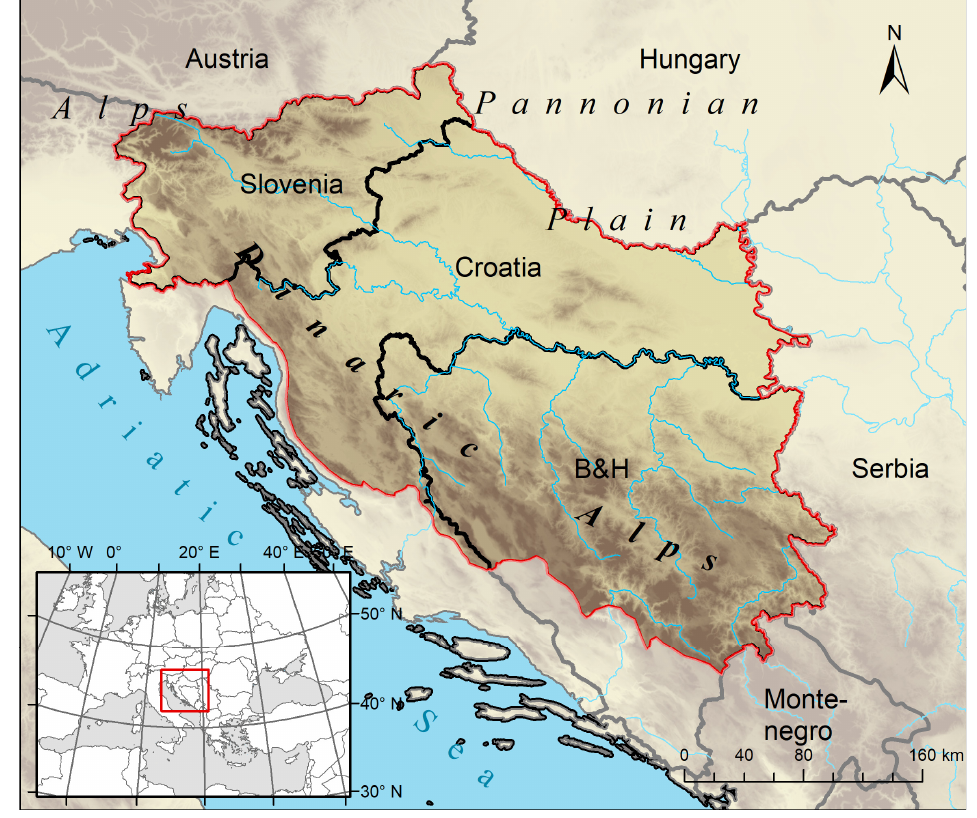
Figure 1. Location of the study area (in saturated tints). Inset map shows the position of the study area in Europe.